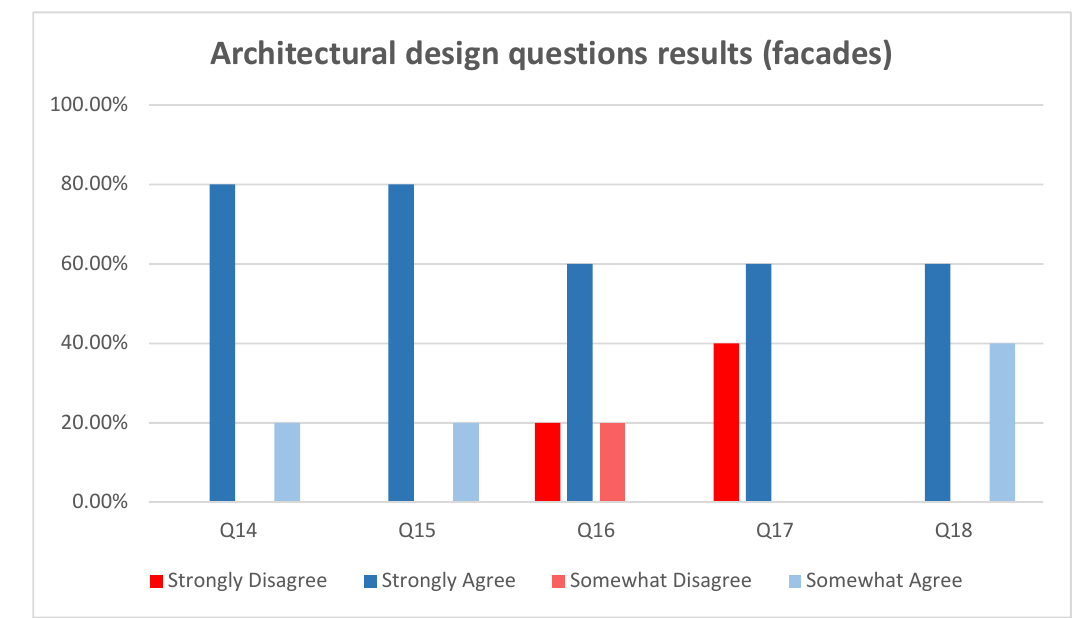
Figure 8. Results of the questions on facades.